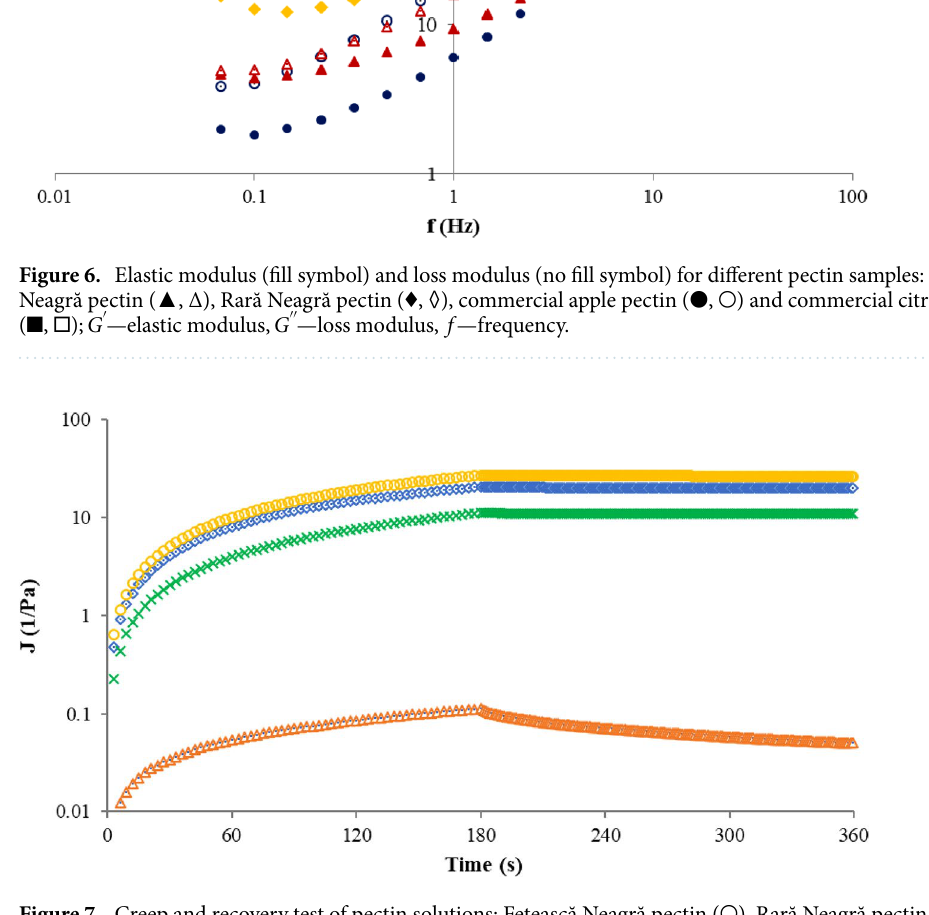
Figure 7. Creep and recovery test of pectin solutions: Fetească Neagră pectin ( ○ ), Rară Neagră pectin ( × ), commercial apple pectin ( ◊ ) and commercial citrus pectin ( ∆ ); J